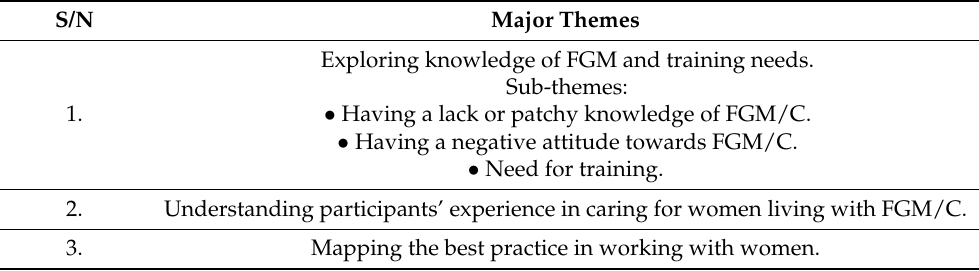
Table 1. Major themes and